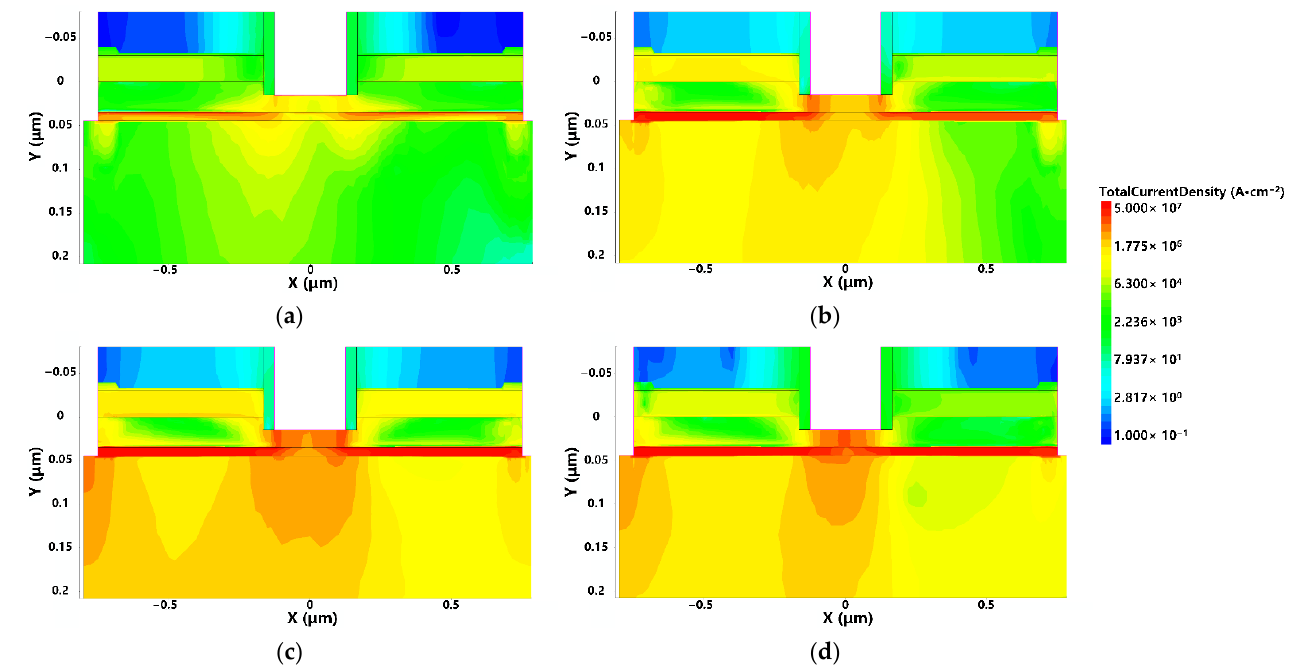
Figure 7. The distributions of current density: ( a ) 0.7 ns; ( b ) 1.0 ns; ( c ) 1.2 ns; ( d ) 1.4 ns.